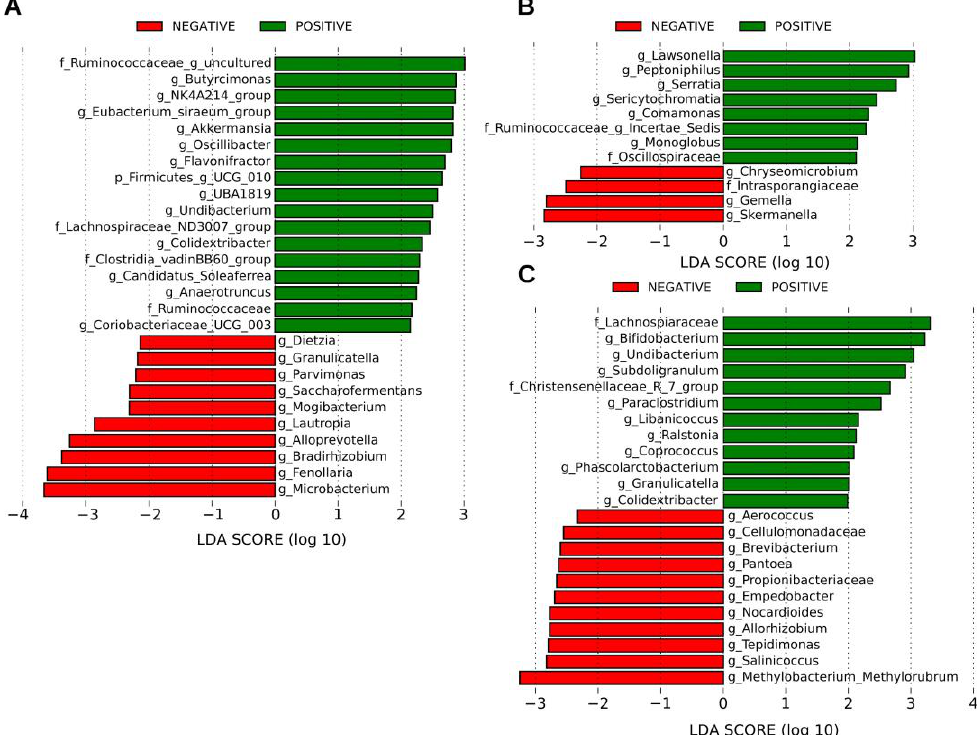
Figure 3. Linear discriminant analysis (LDA) effect size (LEfSe) comparison of differentially abundant bacterial taxa. The figure shows data for ( A ) MRS (mother rectal swab), ( B ) HC (human colostrum), and ( C ) NRS (neonate rectal swab). The effect size for each significant taxon is represented as the log 10 transformed LDA score shown by the length of the horizontal bars. The threshold on the logarithmic LDA score for discriminative features was set to 2.0. The names of bacterial taxa with a statistically significant change in relative abundance characterizing each condition are written alongside the horizontal lines. Positive (green color) or negative (red color) SARS-CoV-2 genome detection by RT-ddPCR is shown on top of each graphic. Taxa categories are “c”, class; “o”, order; “f”, family, and “g”, genus. See Supplementary Materials Table S8 for full taxon descriptions and LDA score p -values and q -values.